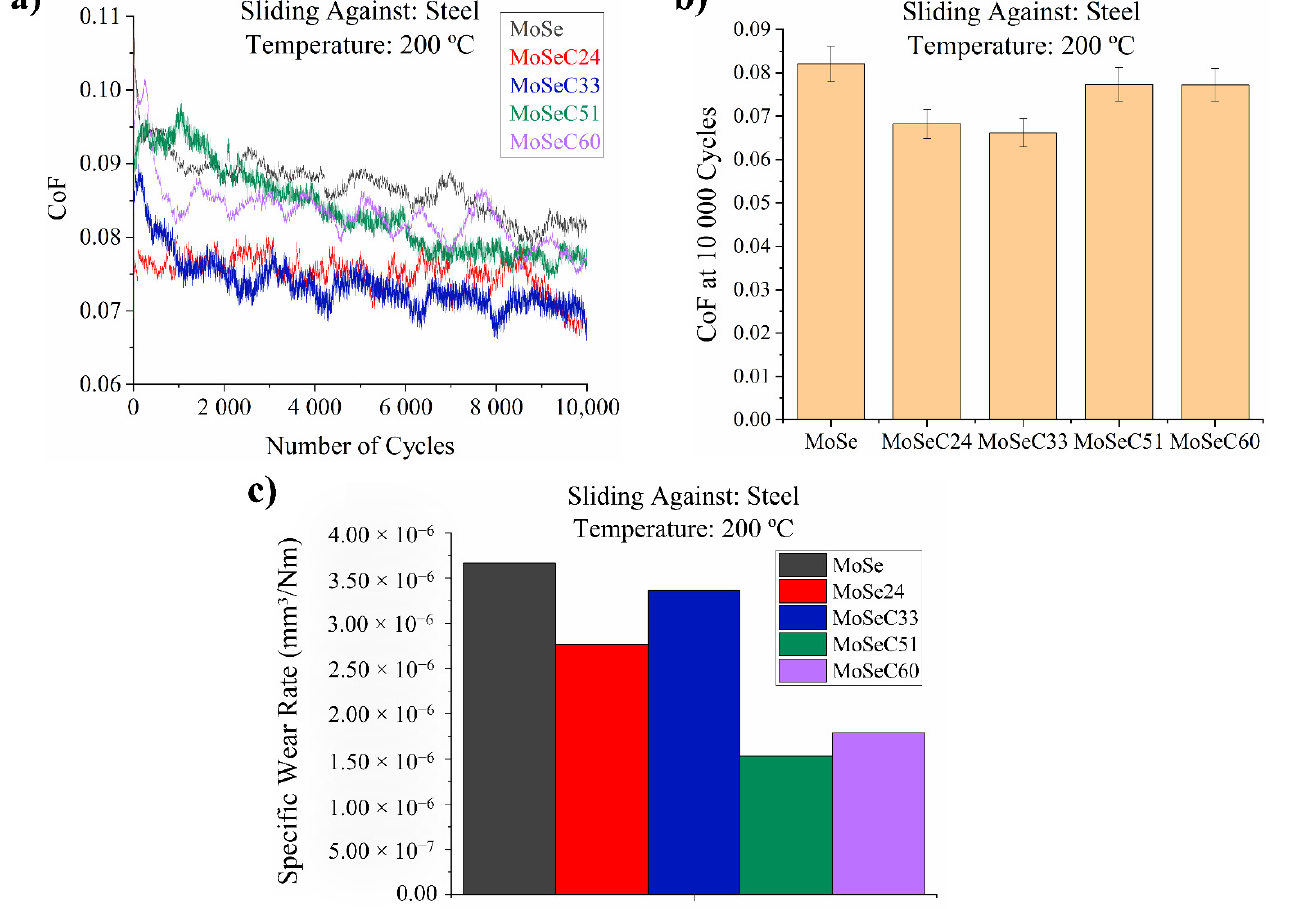
Figure 8. Results of the POD tests, performed against a steel countersurface, at 200 ◦ C: ( a ) friction curves; ( b ) final CoF; ( c ) specific wear rates obtained via 3D optical